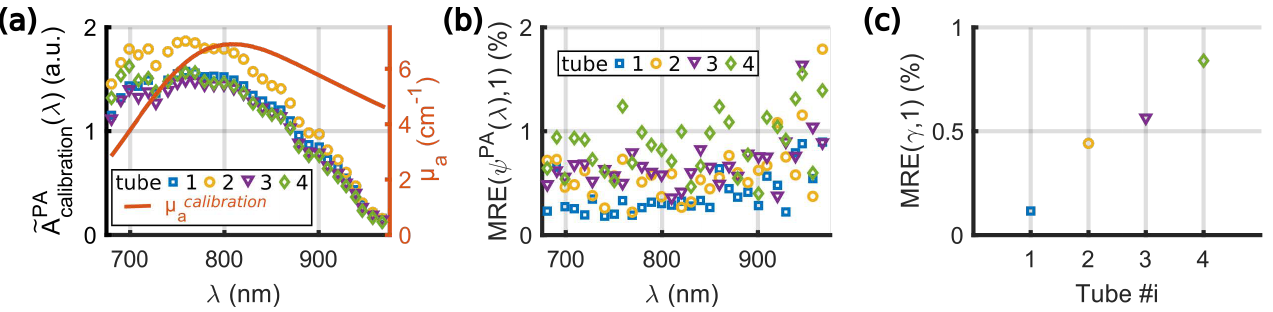
Figure 4. Repeatability of measurements with the calibration solution evaluated with 10 acquisitions. Different experimental conditions were applied for the 4 tubes. Tube 1: the solution was injected once. Tube 2: the solution was re-injected. Tube 3: the tube was flushed with air, and the solution was re-injected. Tube 4: the tube was flushed with air and water, and the solution was re-injected. ( λ ) used for the evaluation of Ψ PA for each tube and the absorption spectrum of the ( a ) (cid:101) A PA calibration calibration solution. ( b ) Median relative error (MRE) of Ψ PA vs. the optical wavelength λ for each tube. ( c ) MRE for the fitting factor of Ψ PA by a flat spectrum of amplitude